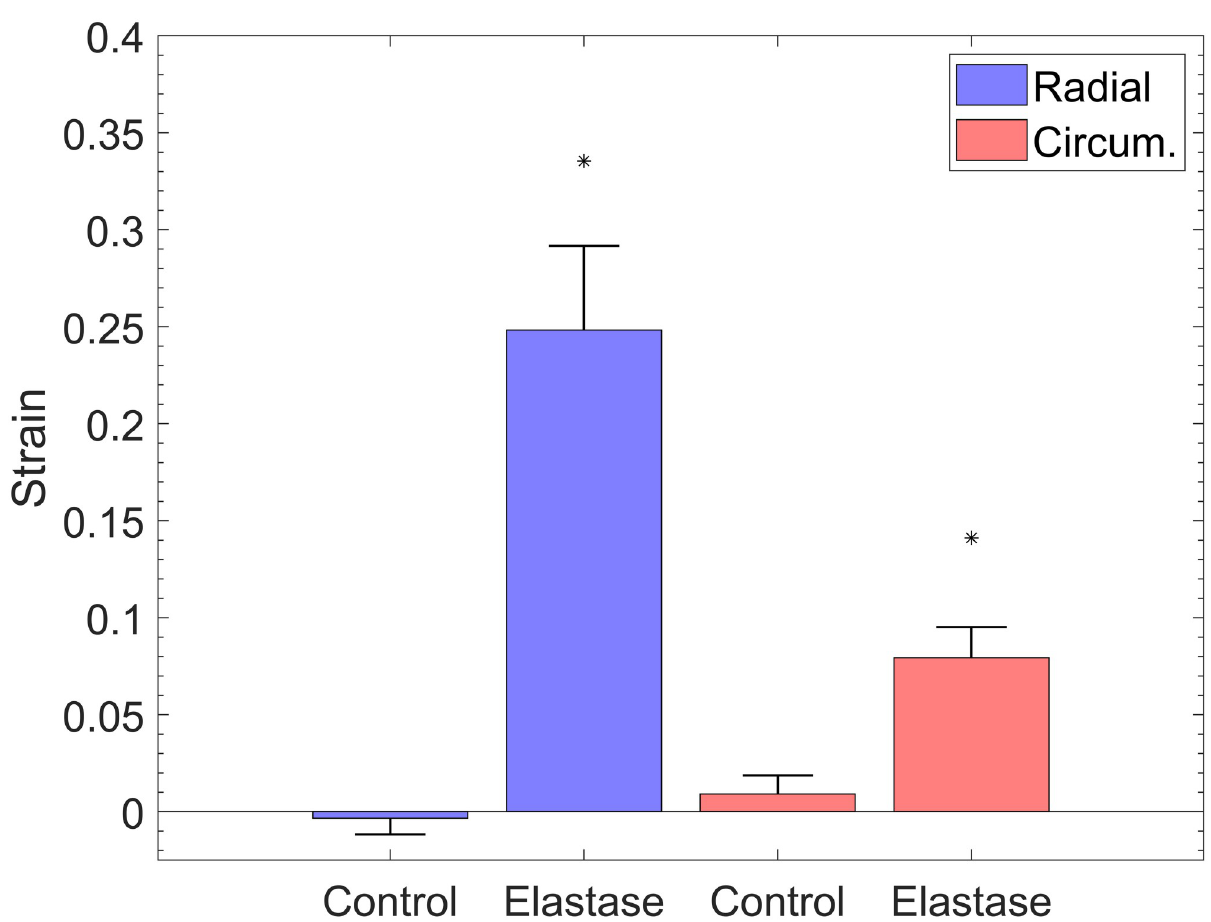
Fig 12. Average strain increase following elastase digestion with reference to pre-elastase marker position at 85 kPa stress level. Asterisk denotes significance ( p < .05). Error bars represent the standard error.